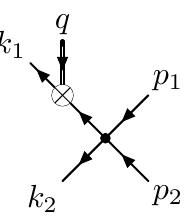
Figure 4 . Tree-level contribution to length-one two-particle form